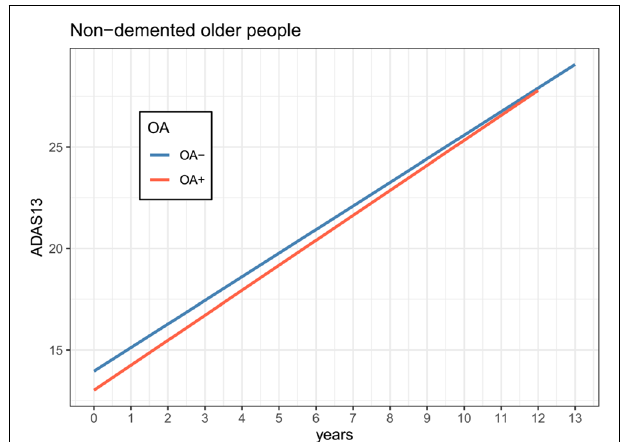
FIGURE 1 | Association of OA status with changes in cognition over time among non-demented older adults. The OA status was not associated with the change in ADAS-Cog 13 over time among non-demented older adults (coefficient = − 0.13, p = 0.08). Abbreviations: OA, Osteoarthritis; ADAS-Cog 13, the 13-item Alzheimer’s Disease Assessment Scale-Cognitive